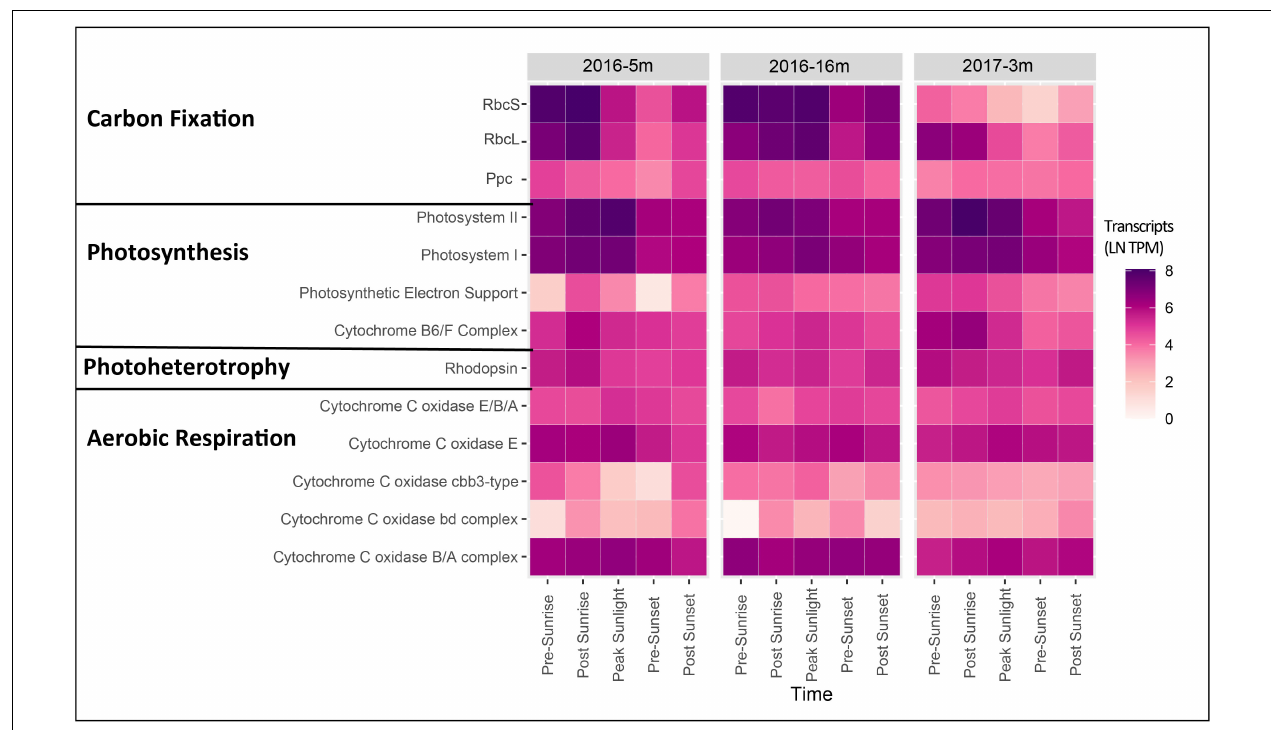
FIGURE 2 | Heatmap showing gene expression [ln(TPM)] for genes associated with carbon fixation, photosynthesis, photoheterotrophy, and aerobic respiration for the photic layers of each cruise. Genes expression for all genes associated with each function was summed to give a final expression for each